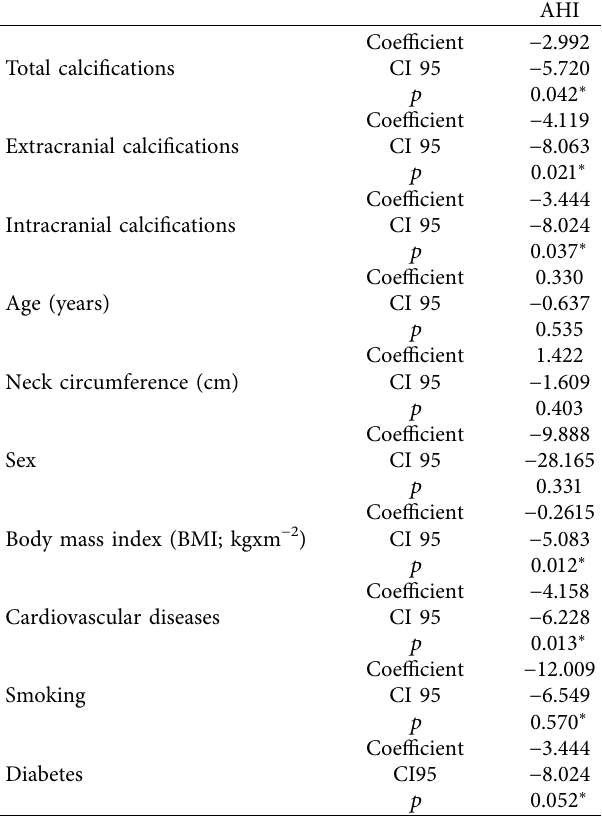
Table 5: Multiple linear regression on the apnea-hypopnea index (AHI) coefficients and their 95% confidence intervals (95% CI) was used to assess the associations to the calcifications with adjustment for sex, body mass index (BMI) neck circumference, and age in OSA